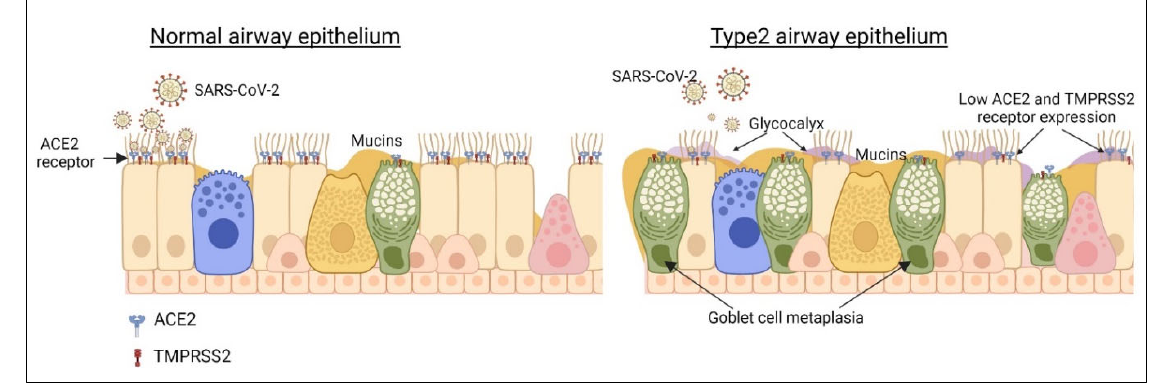
Figure 3. Proposed mechanism by which type 2 immunity may restrict SARS ‐ CoV ‐ 2 virus entry and replication in the airway epithelium. Type 2 cytokines, particularly IL ‐ 13, induce goblet cell metaplasia in the epithelium, which results in a greater number of secretory cells in the epithelium and reduced ciliated cells. This results in reduced virus binding as ciliated cells stand a greater tropism towards the virus. IL ‐ 13 also reduces ACE2 expression in epithelium and TMPRSS2 in ciliated cells. IL ‐ 13 enhances mucin secretion and glycocalyx secretion in the periciliary area, restricting virus attachment. Created with BioRender.com.